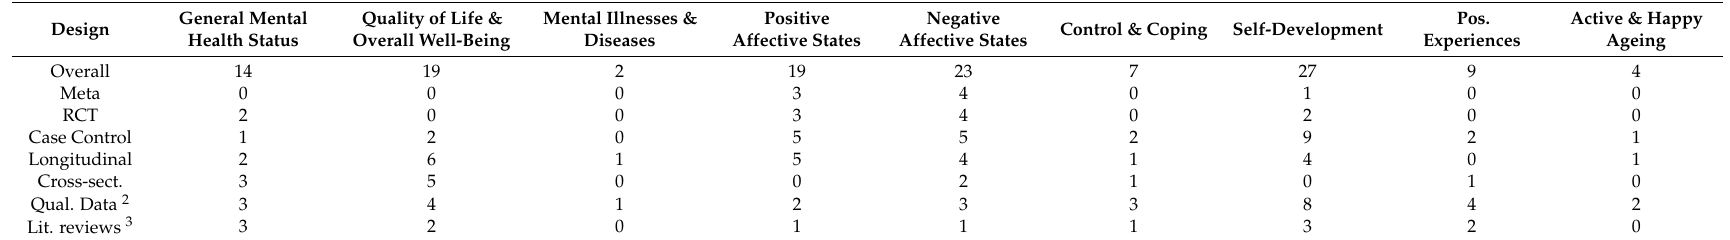
Table 5. Design of studies within mental health and wellbeing impacts 1